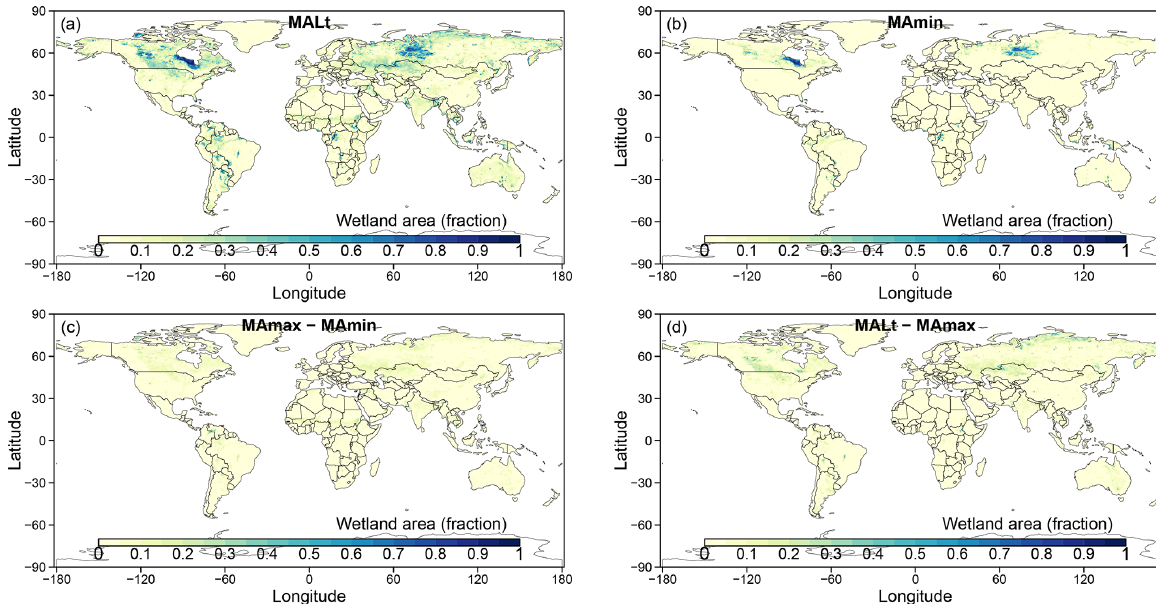
Figure 3. Maps of wetland extent in WAD2M for (a) long-term maximum (MA Lt ), (b) mean annual minimum (MA min ), (c) mean annual magnitude (MA max minus MA min ), and (d) intermittent inundated (MA Lt minus MA max ).